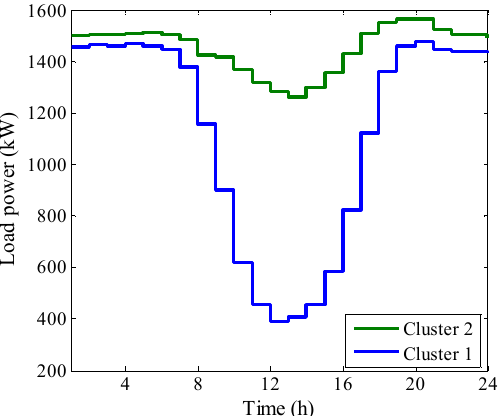
Figure 8. The cluster center curves of two load clusters obtained by the GMM method. Table 5. The total profits in different scenarios and capacity of energy storage.